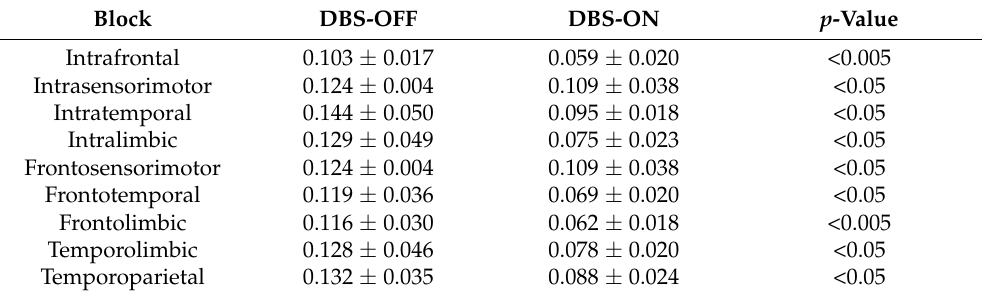
Table 2. Significant differences in block-based mean β FC between DBS-OFF and DBS-ON conditions.